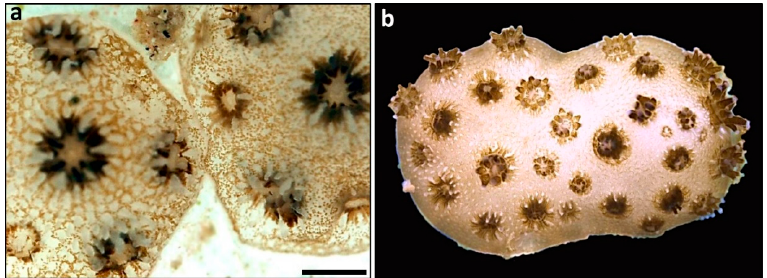
Figure 2. Coral chimerism. ( a ) Two contacting young spats (about 1 month old) of the Red Sea branching coral Stylophora pistillata , during the process of fusion (bar = 2 mm); ( b ) a several months old chimera of Stylophora pistillata , before the initiation of up-growing branches. Morphologically undistinguished area of fusion.